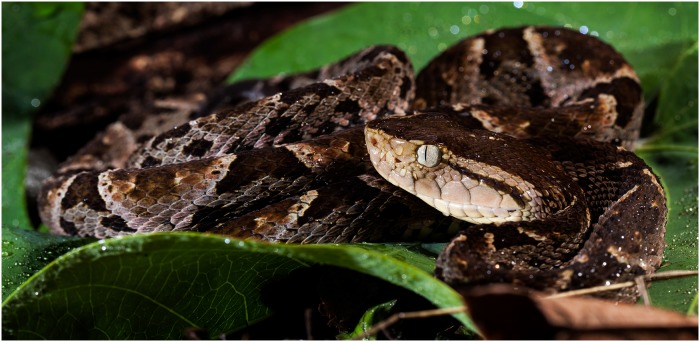
Study species: Terciopelo pit viper, Bothrops asper.This species is responsible for most snakebite envenomation throughout its distribution. It is distributed in humid lowlands from southern Mexico to northeastern South America. Photography was taken by Bravo-Vega CA.